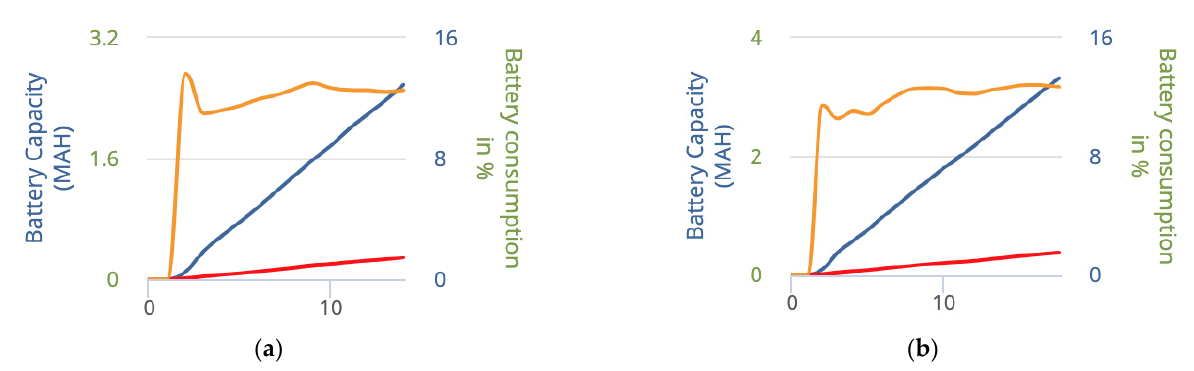
Figure 17. Battery consumption in % of device and mAh of ( a ) Median-4 and ( b ) Kalman-4 imple- mentation (time axis in minutes).